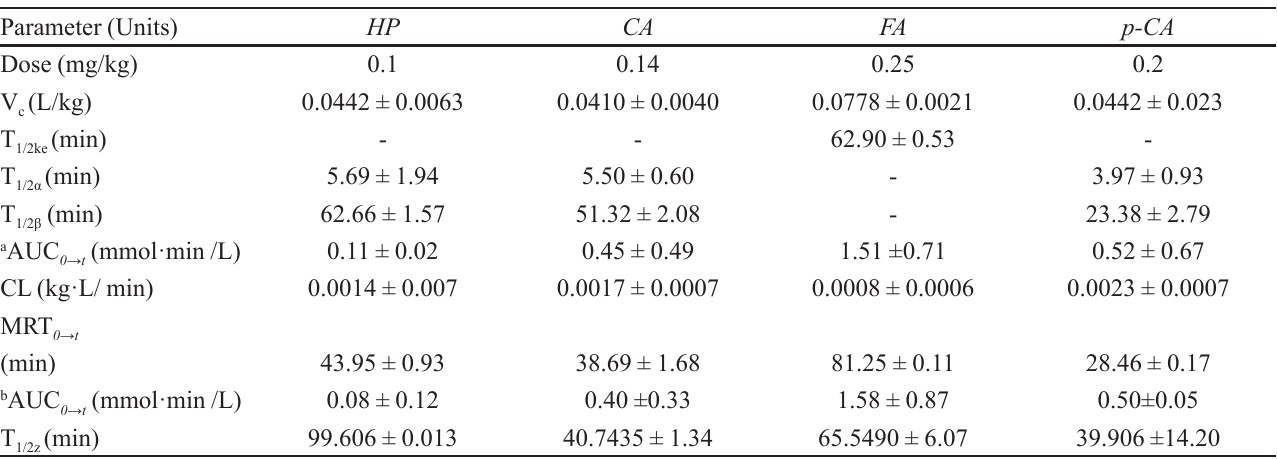
FIGURE 3 - Mean plasma concentration-time of (a) hesperidin, (b) caffeic acid, (c) ferulic acid and (d) p -coumaric acid in rats after intravenous administration of TABLE II - Pharmacokinetic parameters of hesperidin, caffeic acid, ferulic acid and p -coumaric acid in rat plasma (mean ± SD, n = 5) after intravenous administration of POE